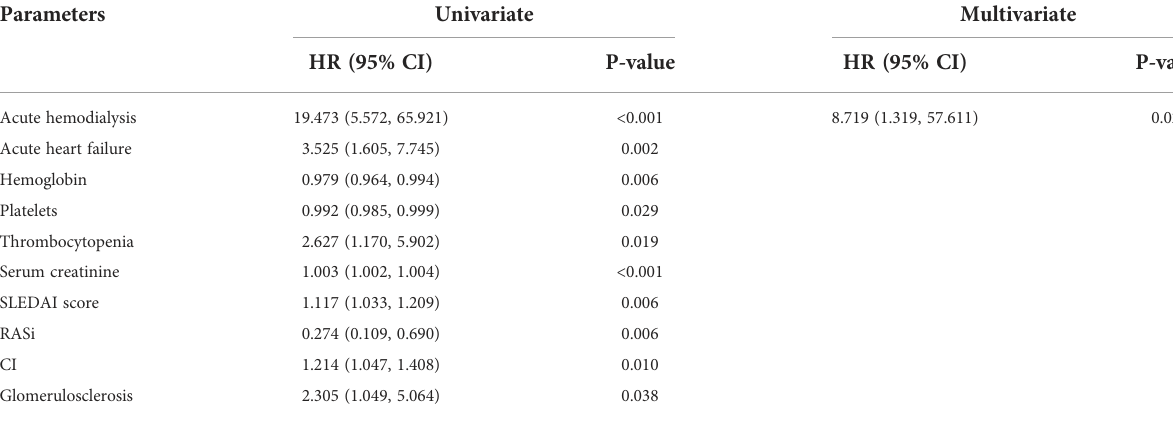
TABLE 7 Risk factors for renal survival determined by univariate/multivariate COX proportional hazard analysis in